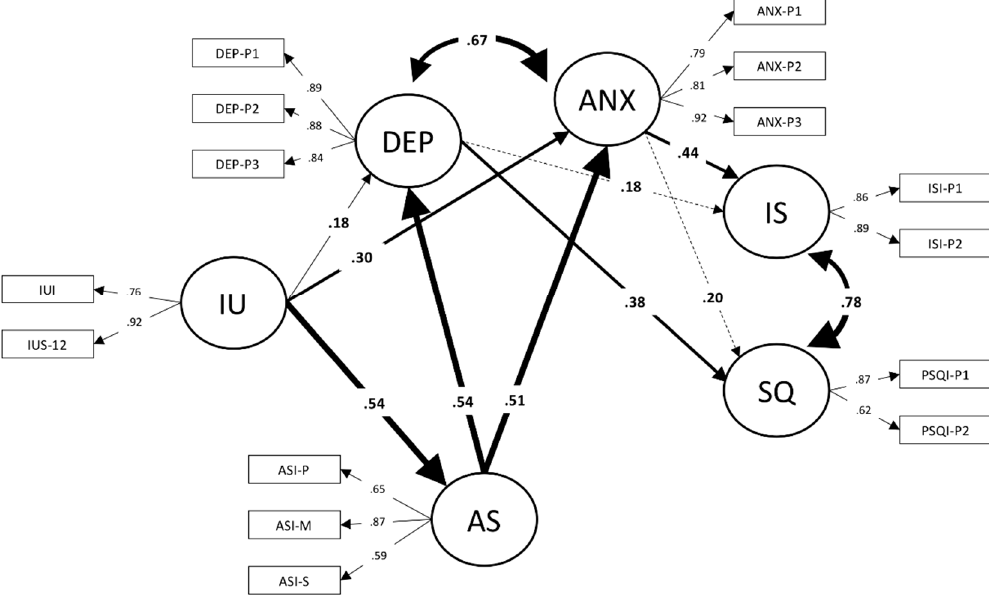
Figure 2. Structural equation model of insomnia severity and sleep quality. IU = Intolerance of Uncertainty; AS = Anxiety Sensitivity; DEP = Depression; ANX = Anxiety; IS = Insomnia Severity; SQ = Sleep Quality. The solid lines represent statistically significant paths ( p < 0.05). The dashed lines represent not significant paths. The thickness of the lines representing structural relationships is proportional to the effect size of the path coefficient.